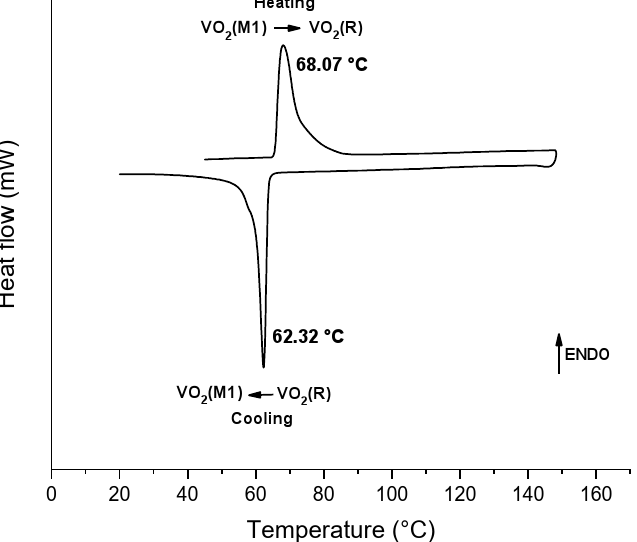
Figure 7. DSC curve of V6 1.7 _12h sample over two heating and cooling cycles, where 68.07 ◦ C and 62.32 ◦ C were the temperatures of the phase transitions VO 2 (M) → VO 2 (R) and VO 2 (M) → VO 2 (R), respectively.